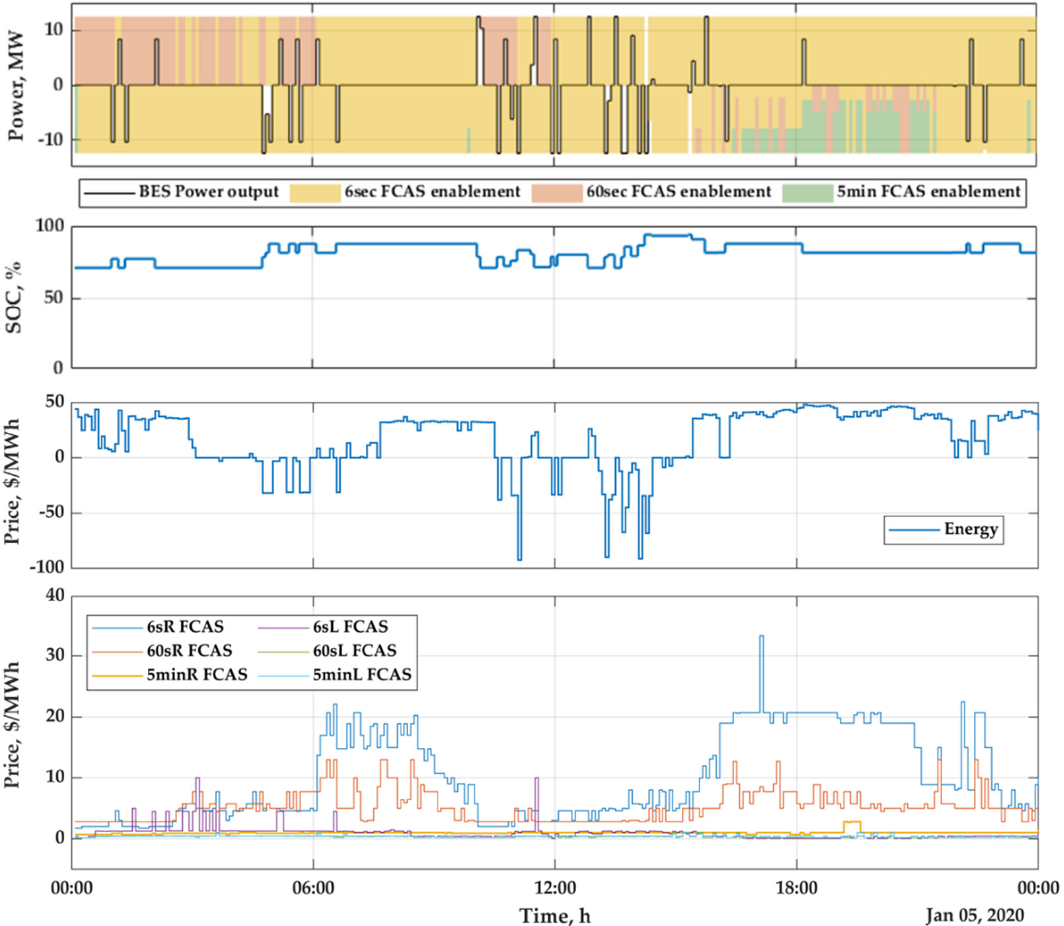
Figure 13. Illustration of battery operation in energy and FCAS markets over a single day for NSW. Top plot: power outputs (positive values—discharging, negative—charging) and FCAS enablement (positive values—capacity reserved for raise FCAS markets, negative—for lower). Second plot: resulting battery SOC. Third plot: energy market price. Bottom plot: FCAS market